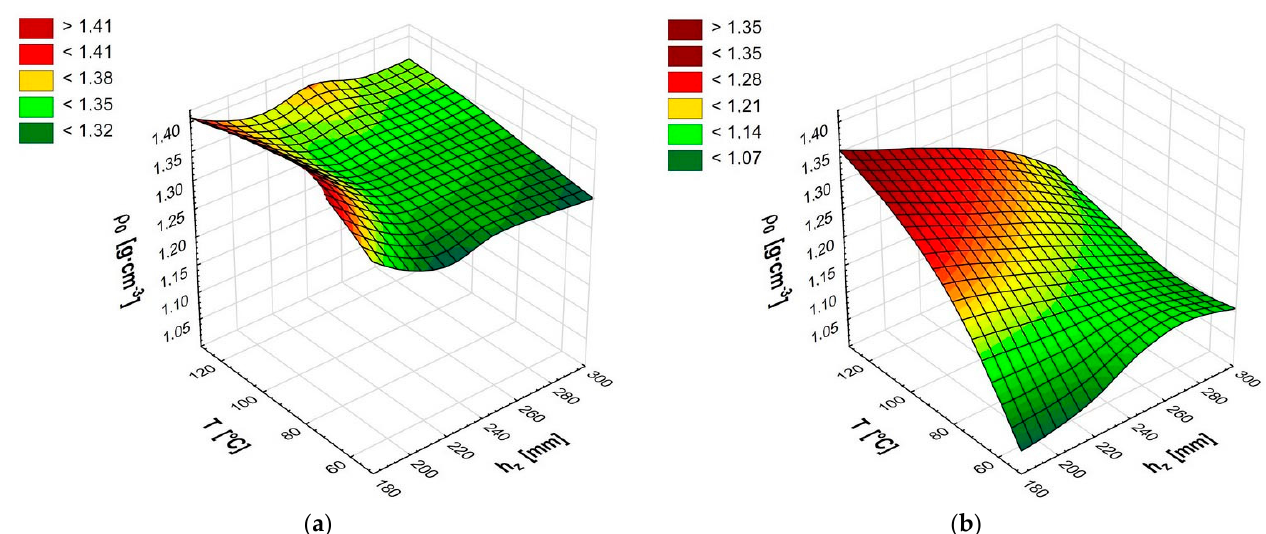
Figure 2. Briquette density inside the die at maximum pressure ρ 0 for moisture content 16% ( a ) and moisture content 9% ( b ).